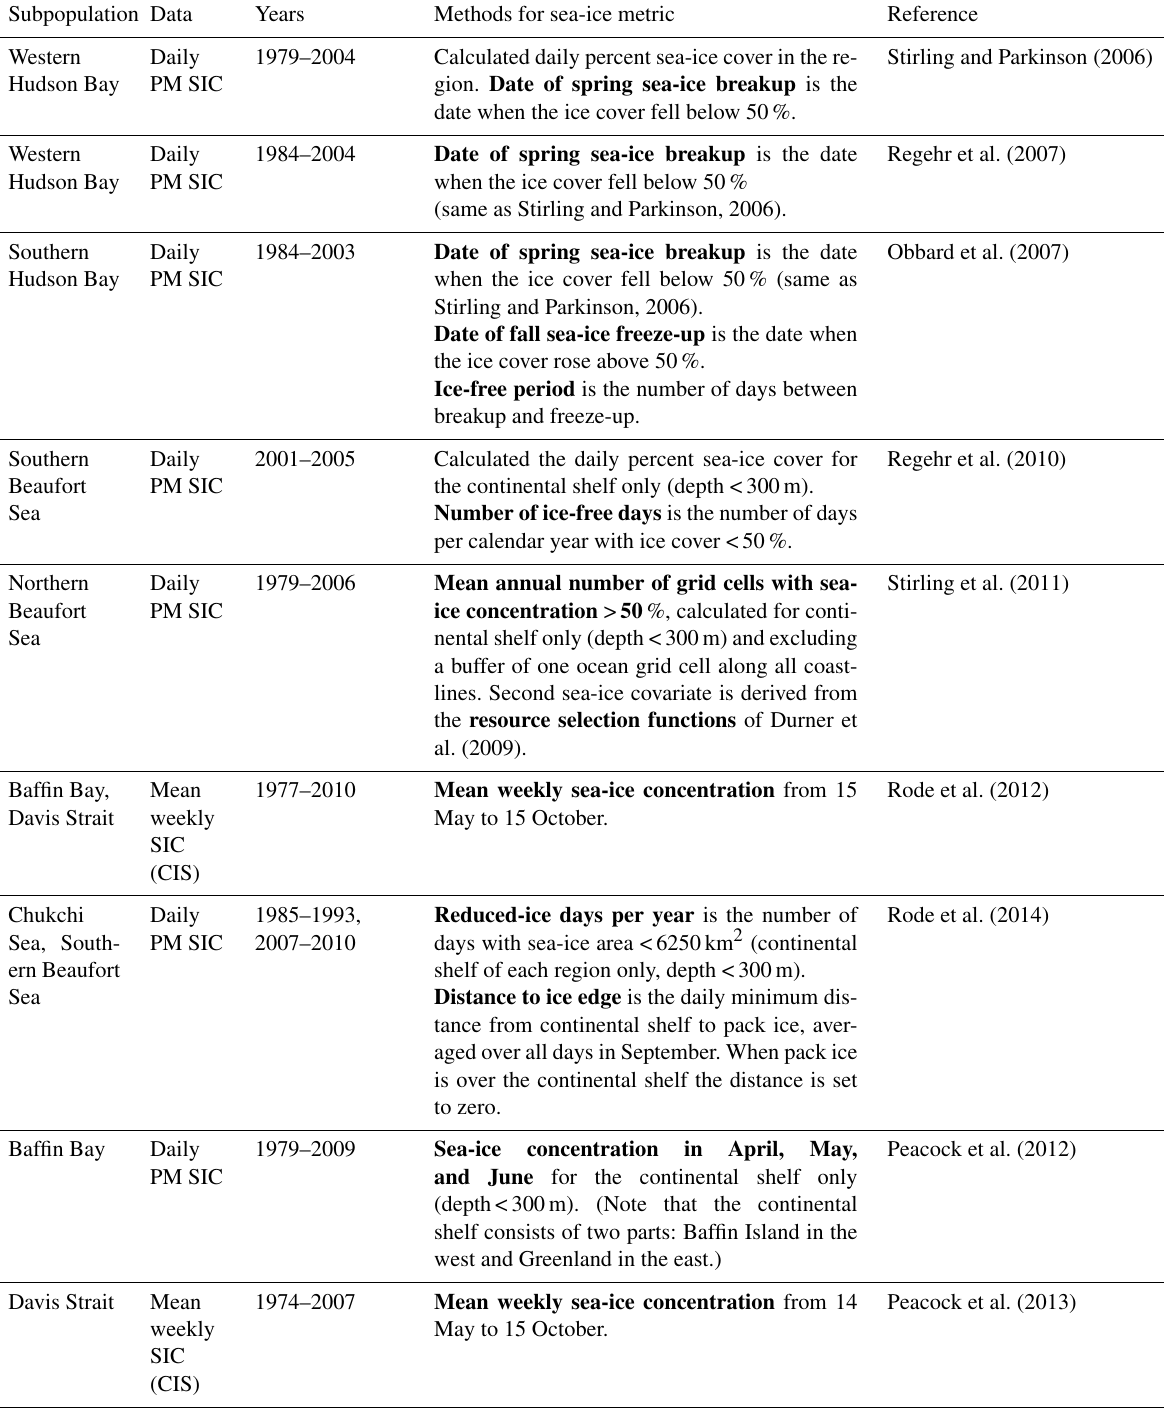
Table 2. Recent literature where sea-ice metrics were used for analysis of polar bear habitat. Note that these studies examined habitat for a single polar bear subpopulation (or geographically close set of subpopulations). Bold text gives names of sea-ice metrics. Abbreviations: PM (passive microwave), SIC (sea-ice concentration), CIS (Canadian Ice